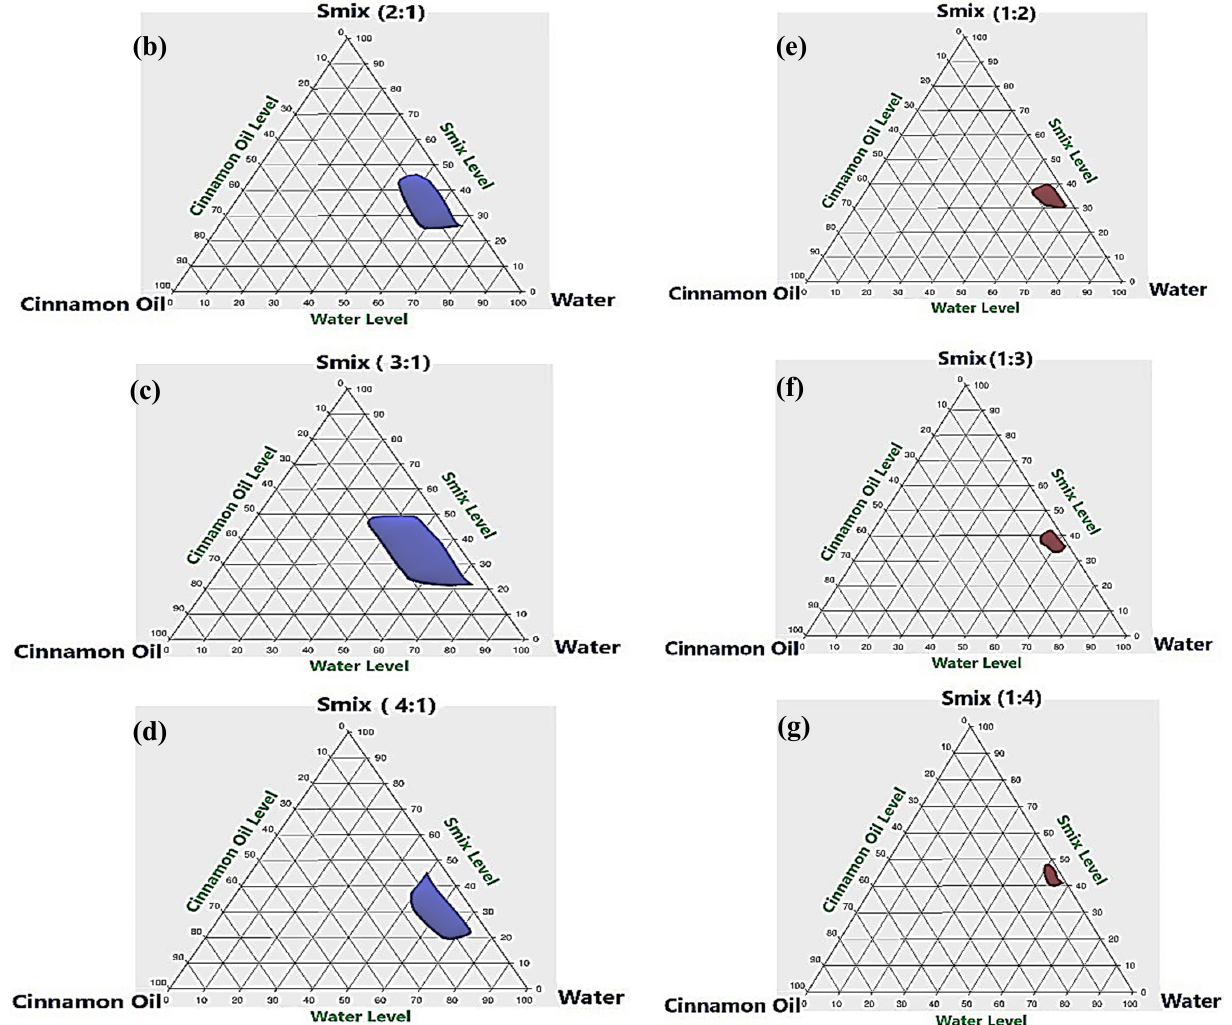
Figure 1. Pseudoternary-phase diagram constructed for the identification of the nanoemulsion region using cinnamon oil (CO), surfactant (Pluracare L44 and Plurol Oleique CC 497 in a ratio of 1:1), and co-surfactant (Capryol PGMC) at different surfactant and co-surfactant mixture (S mix ) ratios: ( a ) S mix 1:1, ( b ) S mix 2:1, ( c ) S mix 3:1, ( d ) S mix 4:1, ( e ) S mix 1:2, ( f ) S mix 1:3, and ( g ) S mix 1:4.